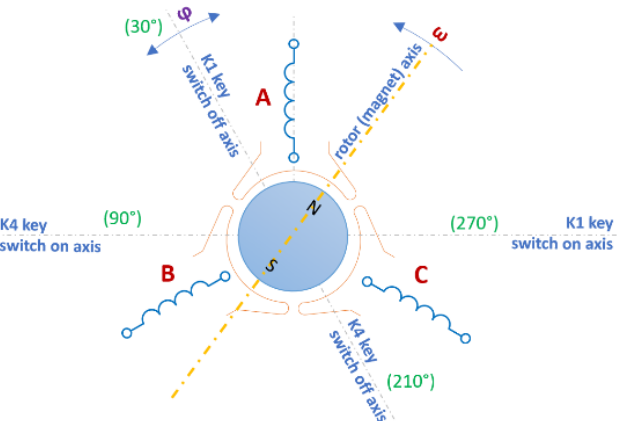
Figure 3. Motor windings with marked axes of switching on one of the bands. Changing the angle φ enables adjustment of the control mode and affects the torque characteristics. In the calculations, the boundary switching point of bands was assumed for such a rotor position in which the mo- mentum is zero.